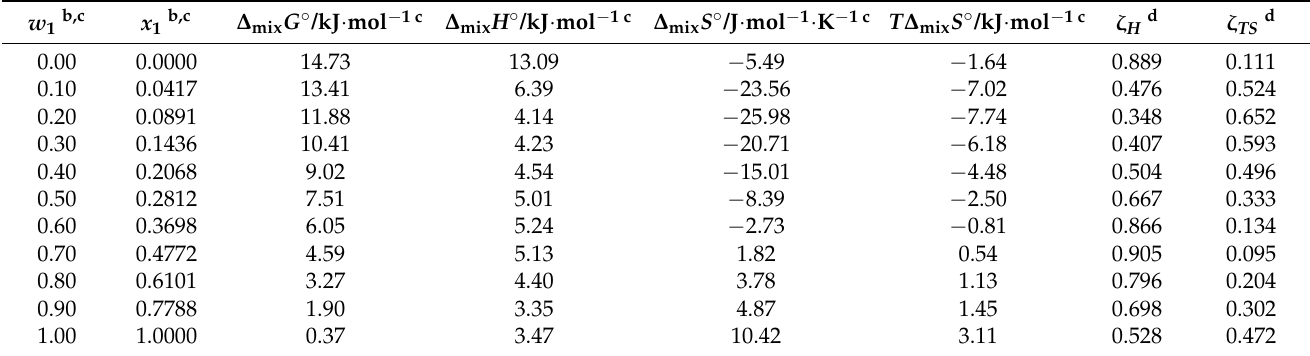
Table 6. Apparent thermodynamic functions relative to mixing processes of benzoic acid (3)